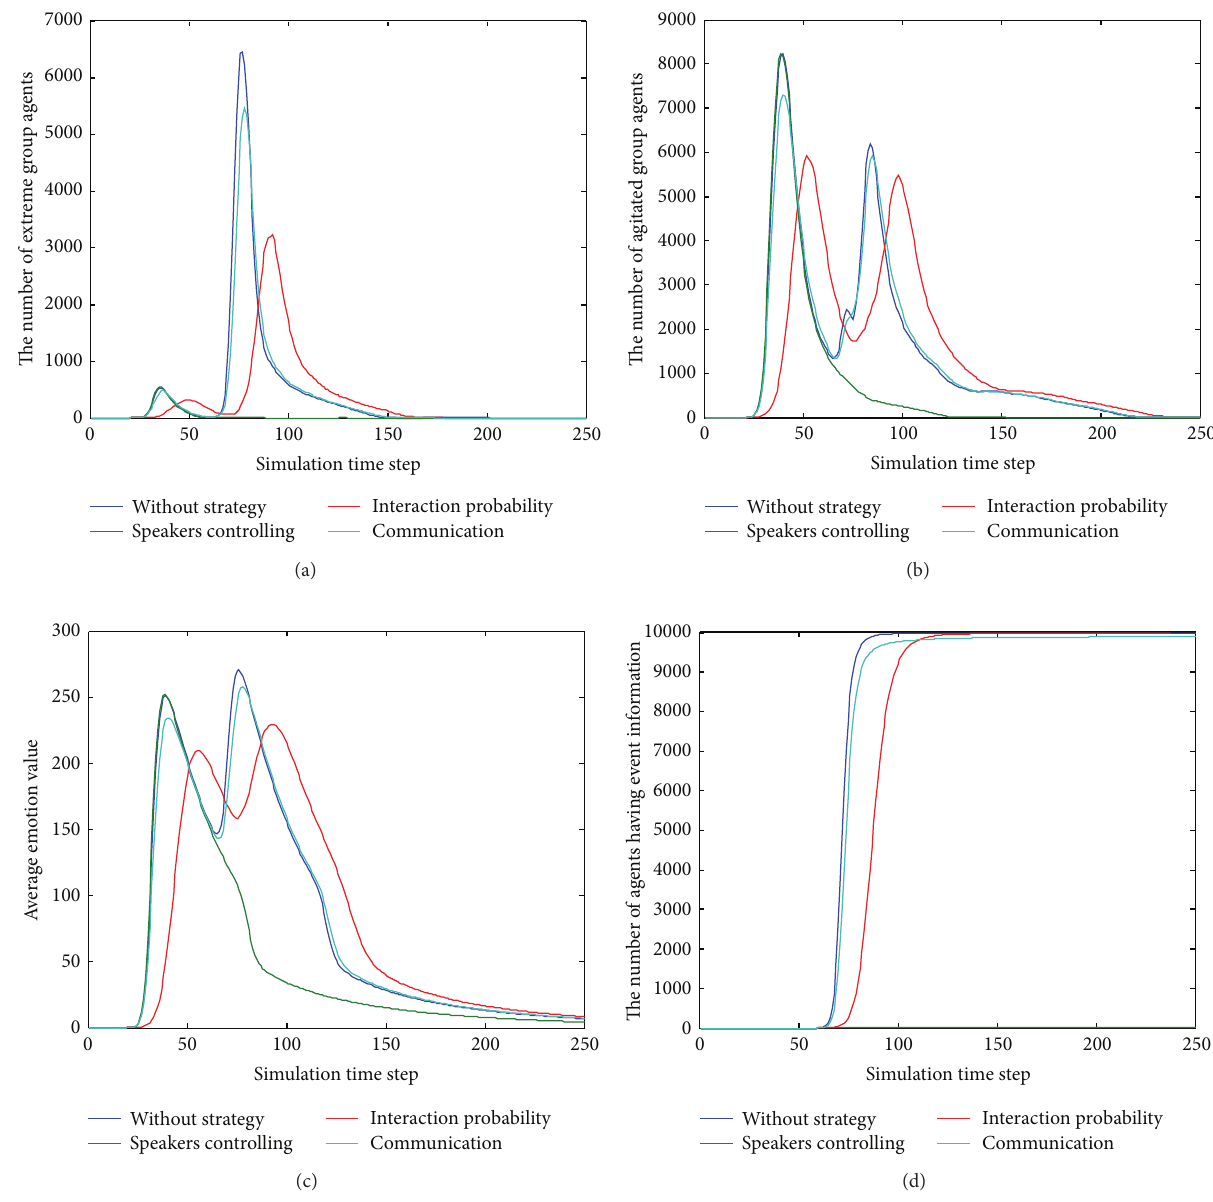
Figure 5: Group emotion evolution curves of successive events: (a) the number of extreme group agents; (b) the number of agitated group agents; (c) average emotion value evolution curves; (d) the information diffusion curves (the second